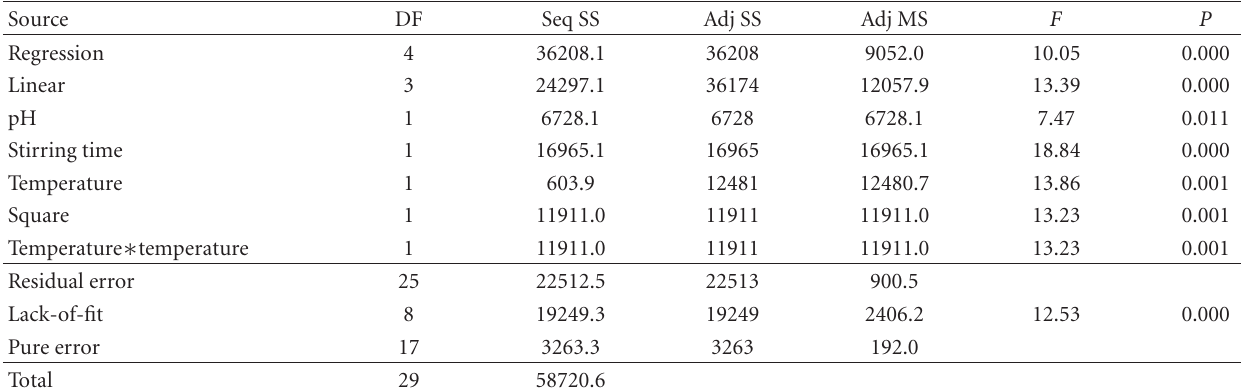
Table 10: Analysis of variance for concentration of leached